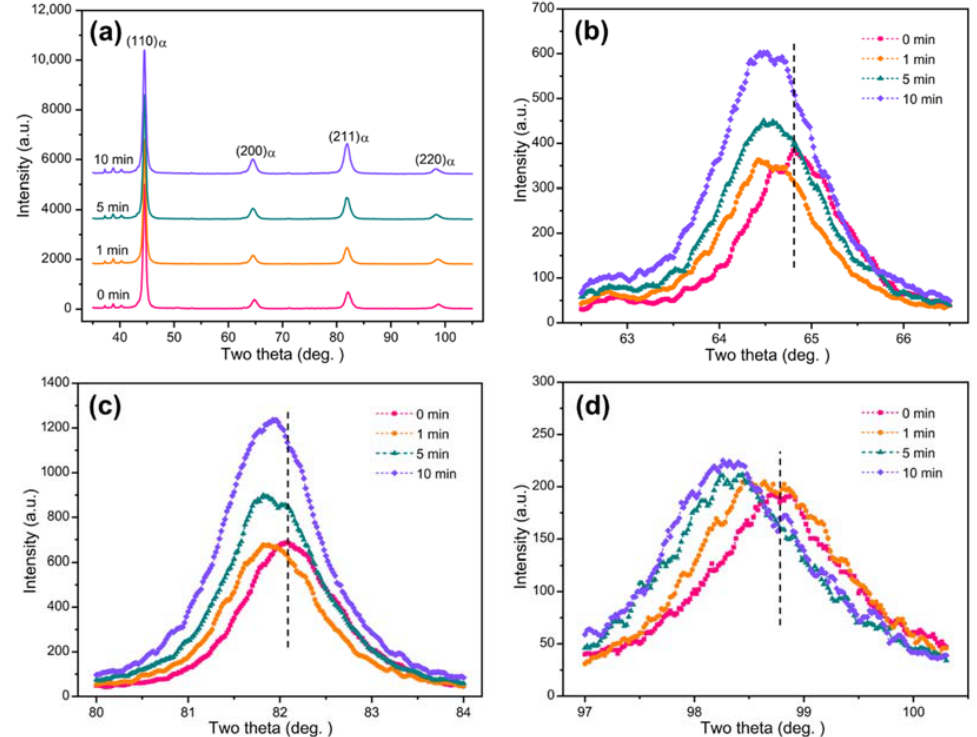
Figure 4. ( a ) XRD patterns of the M50 steel with different USP durations; ( b ) (200) α peak; ( c ) (211) α peak; ( d ) (220) α peak.